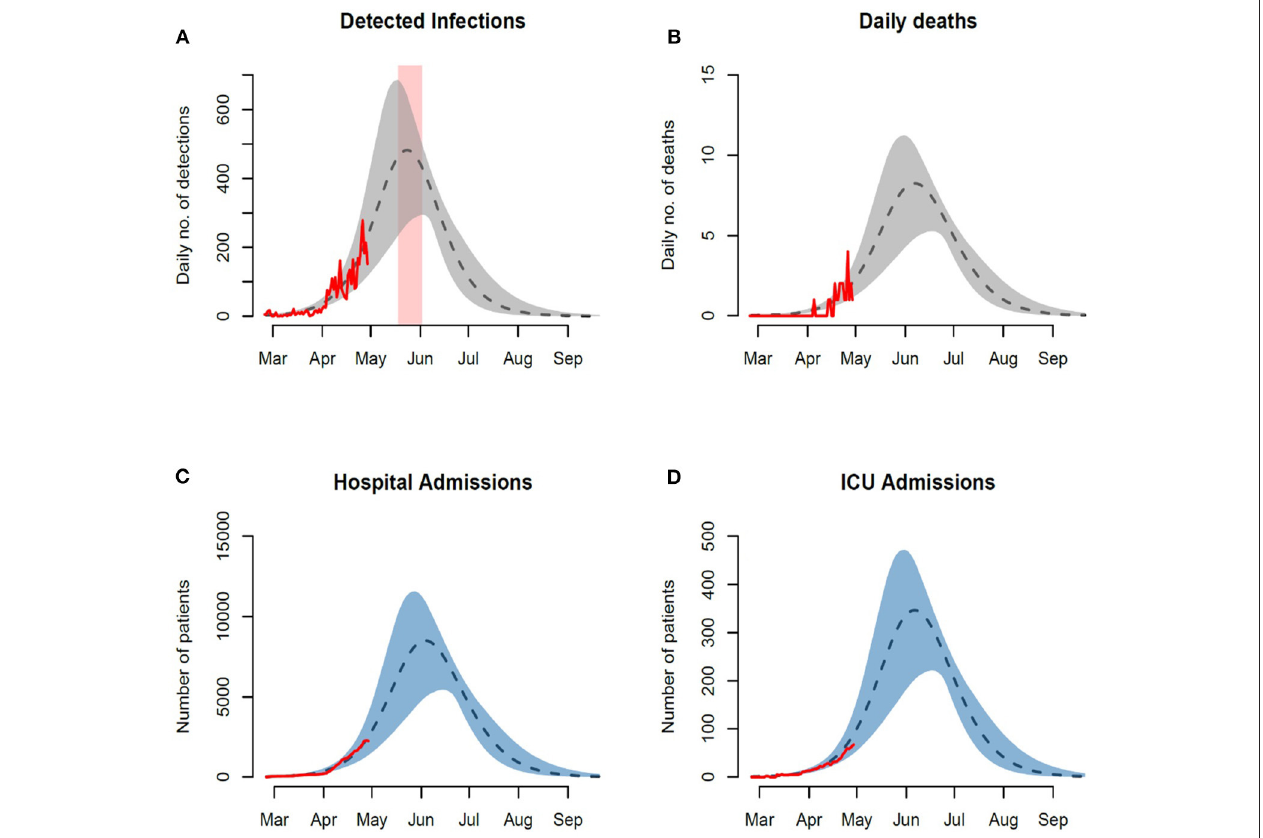
FIGURE 3 | Observed and forecasted trajectories assuming 500,000 unprotected susceptible individuals. Observed and projected daily numbers of (A) incident infections, (B) death cases, (C) general hospital admissions, and (D) ICU admissions. Red rectangular ribbon highlights the projected time-window of the epidemic peak. Red lines represent the reported data. Black dashed lines represent model projections based on MLE of unknown parameters with shaded ribbons representing 95% credible interval on new observations. We note here that the observed cases and their projections only represent a fraction of the actual and model prevalence. This is based on our assumption of under-reporting and the presence of asymptomatic individuals in the population.